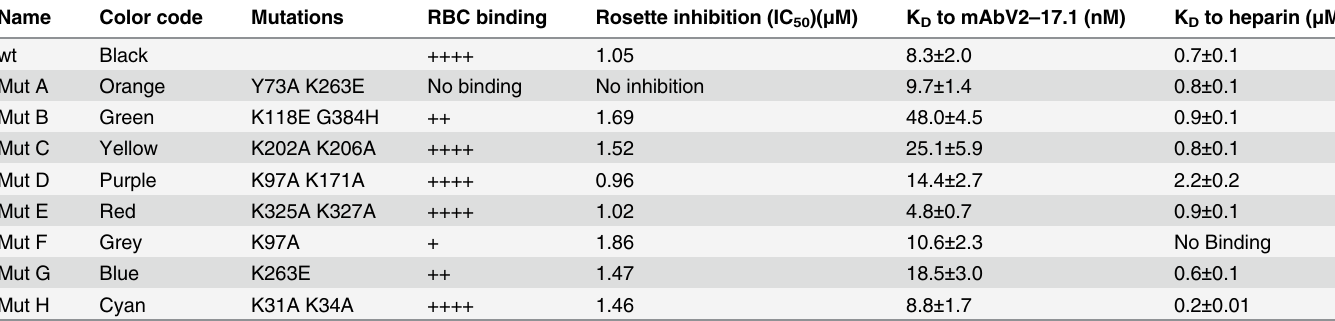
Table 1. Binding capacity and af fi nity of recombinant NTS-DBL1 α (It4var60) variants to RBCs and ligands.